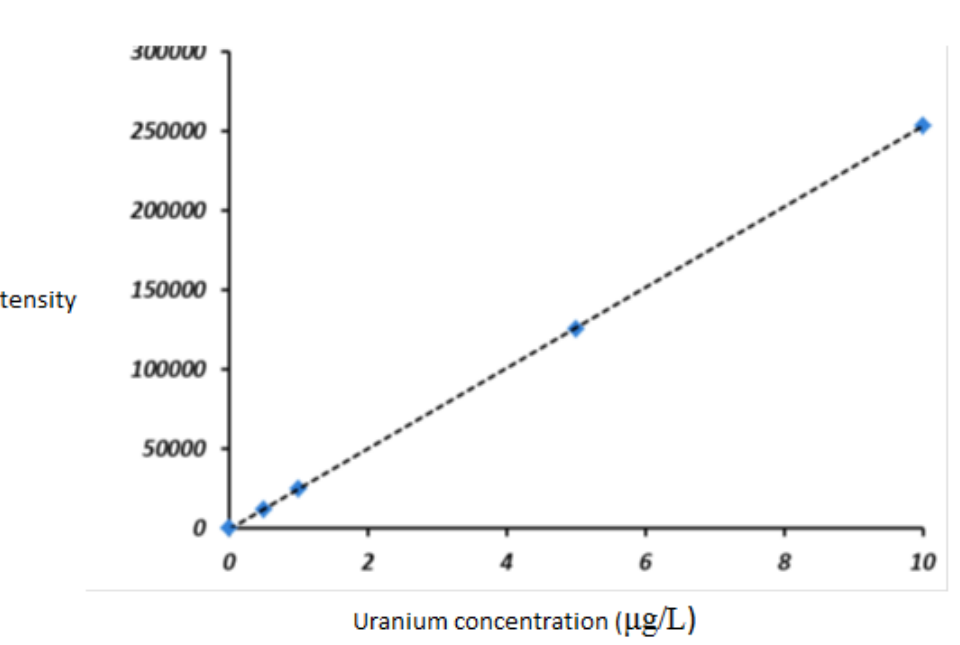
Fig. 3: Calibration curve of uranium concentration